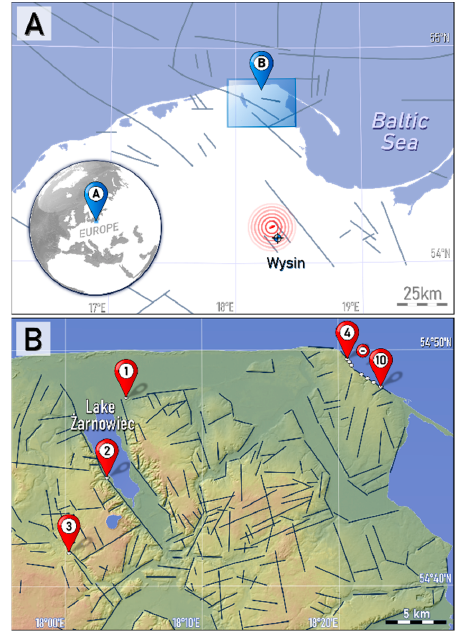
Figure 3. ( A ) The locations of the Wysin hydrofracturing site and epicenter of the M w 2.8 earthquake from 15 June 2019 in the Gda ń sk Pomerania region. Lines indicate the locations of faults. Circular inset A shows the region location in Europe. Inset B shows the location and area of subfigure ( B ). ( B ) The part of the Gda ń sk Pomerania region where the studies of gravels bearing fractured clasts were conducted. The locations of the studied exposures are indicated by pins 1–10. Lines indicate the location of lineaments.